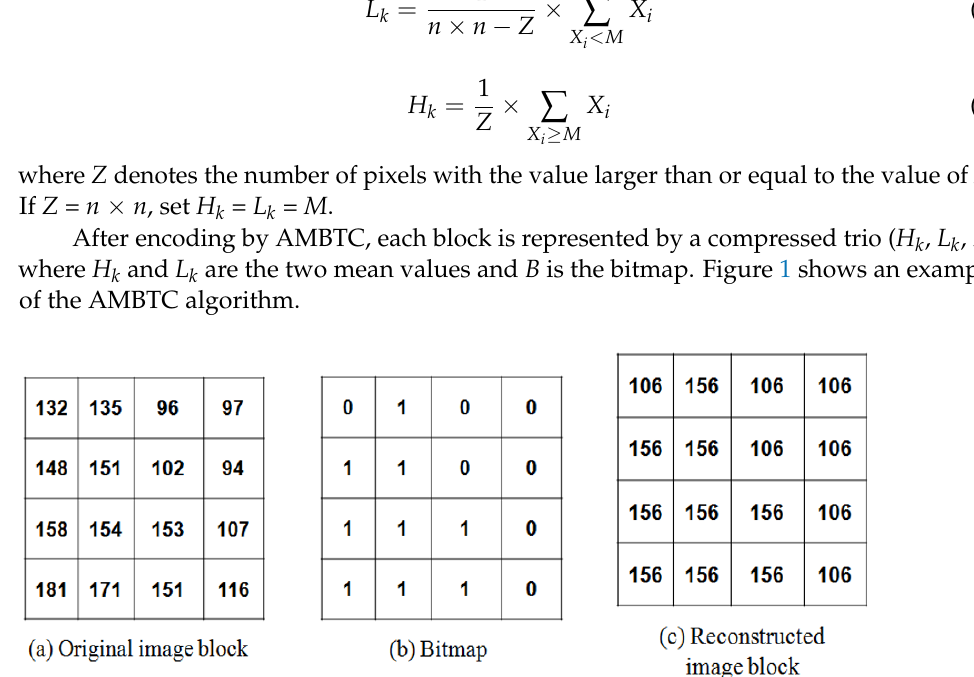
Figure 1. Example of the AMBTC algorithm.